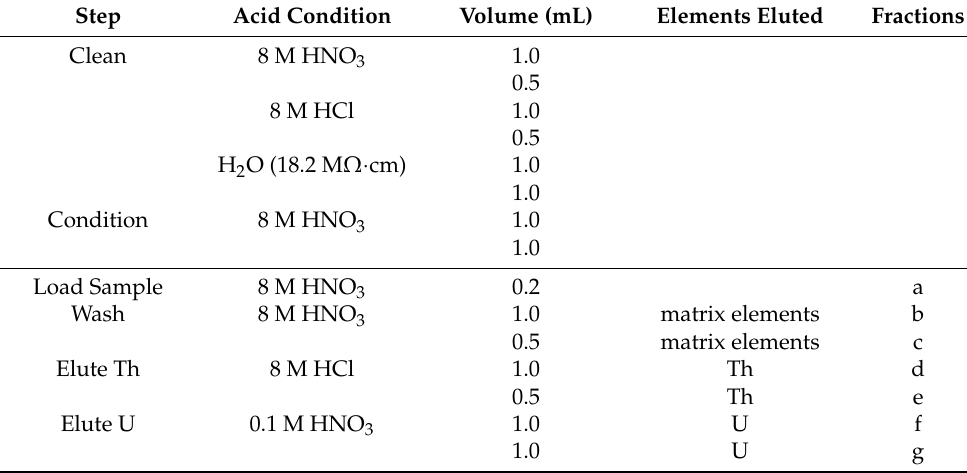
Table 1. U and Th separation using an AG 1-X8 resin